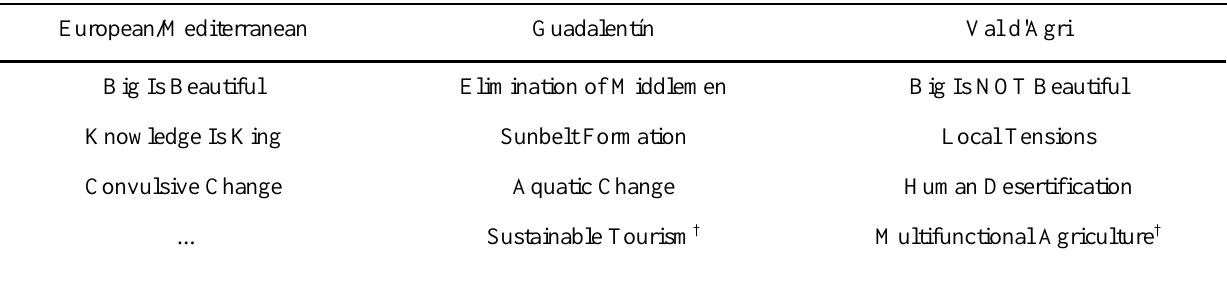
Table 3 . Link between a selection of the scenarios developed at different scales in MedAction. Scenarios at lower levels were developed given the higher-level